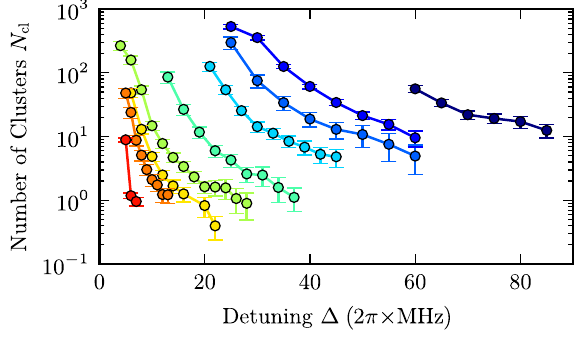
FIG. 4. Number of clusters N calculated from the experi- cl mental data using Eq. (15) for the different detunings and Rabi frequencies. For decreasing detuning, the number of clusters increases steadily, exceeding the size of a cluster by roughly 1 3. Experimentally measured correlation time τ ð 2 Þ ¼ τ cl order of magnitude. The color code corresponds to the same (left scale), corresponding to the lifetime of a cluster in the full Rabi frequencies as in Fig. 3. The error bars correspond to the antiblockade regime Δ > 0 for different Rabi frequencies Ω . The statistical uncertainties from fitting the cluster lifetime τ as well cl cluster lifetime increases with decreasing detuning for fixed Rabi Γ as the multiparticle seed rate N at seed frequency. Using the cluster model, we extract a typical cluster size ¯ m (right bar). The gray dashed line indicates the spontaneous 20 μ s. Inset: The bunching decay time of a single atom τ sp ¼ amplitude g ð 2 Þ ð 0 Þ − 1 shows peaks at detunings, which corre- spond to a cluster size of approximately two. Error bars correspond to the statistical uncertainty from fitting an exponen- tial decay to the experimental retrieved correlation function. For simplicity, they are not shown in the